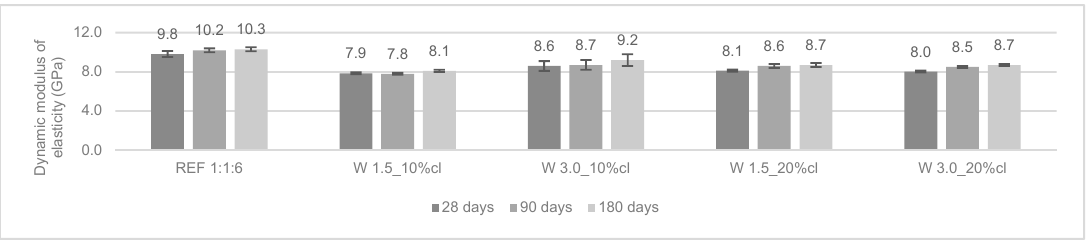
Figure 6. Dynamic modulus of elasticity of the cement-lime mortars.